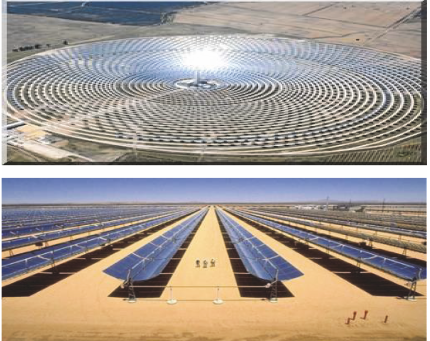
Figure 1: First part of the Moroccan Solar Plan “ Noor1 ” inaugurated on February